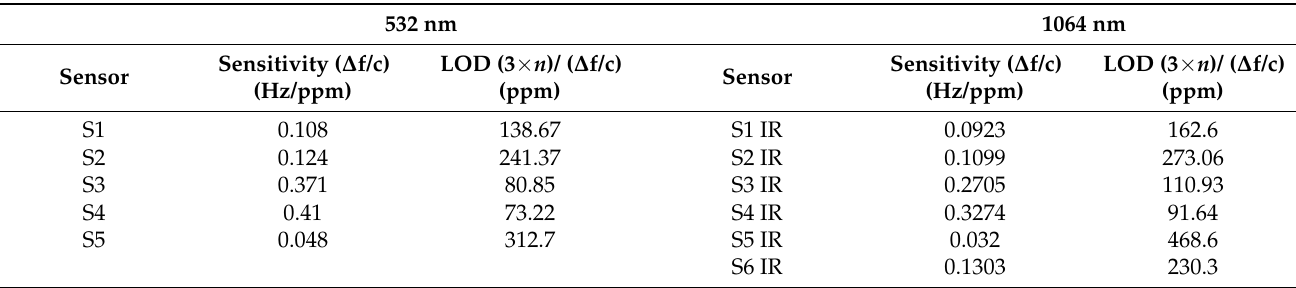
Figure 11. Sensor response to various H 2 concentrations. ( a ) Sensitive films deposited with 532 nm laser radiation. ( b ) Sensitive films deposited with 1.06 µm laser radiation. Table 2. Sensitivity and limit of detection (LOD) of the sensors. Legend: ∆ f—frequency change; c—hydrogen concentration; n —noise level.